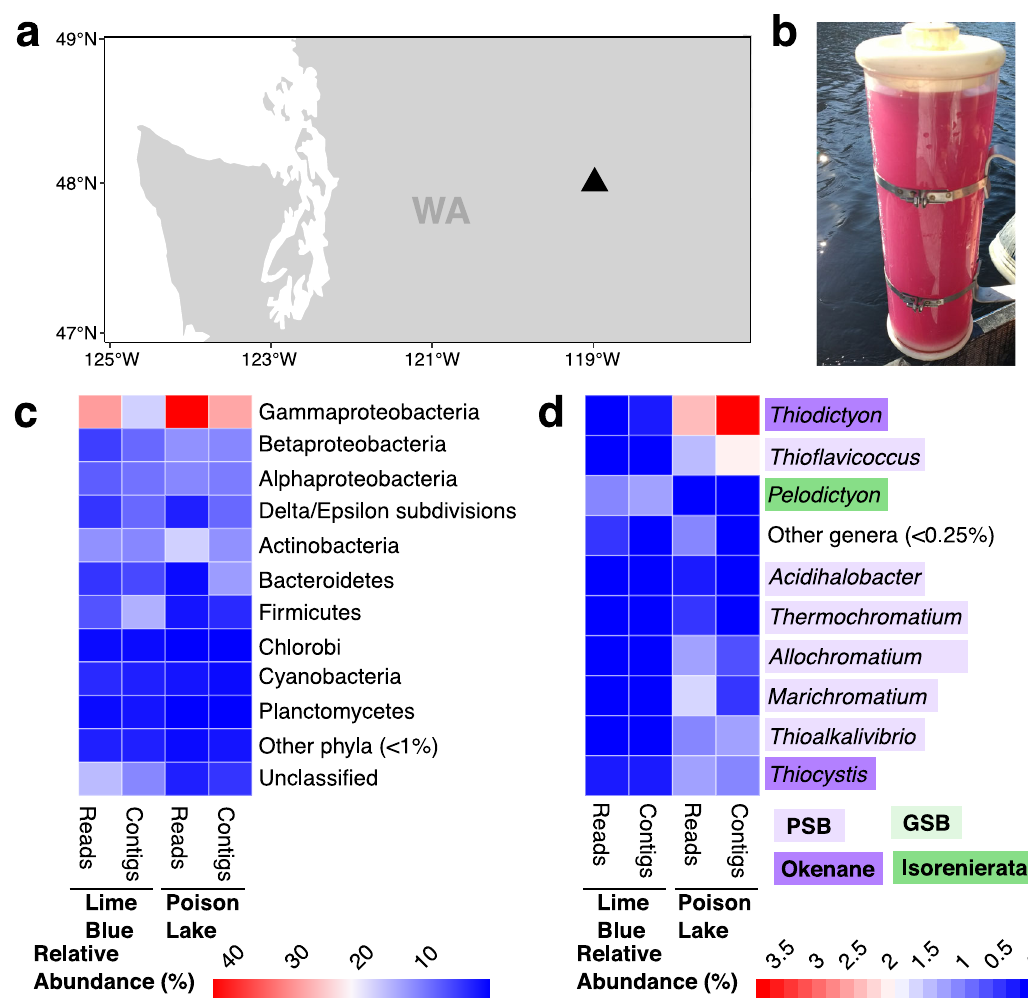
Fig. 1 Sampling sites and bacterial community composition of the two study sites. a Geographic location of sampling sites Poison Lake and Lime Blue in Washington (WA), U.S. b Poison Lake water sample displaying PSB bloom. c Phylum-level read and contig abundances with members of the phylum Proteobacteria split into class level, and ( d ) genus-level abundance of Chlorobi, Chromatiaceae and Ectothiorhodospiraceae . The two sampling sites are denoted as LB, for Lime Blue, and PL for Poison Lake. PSB are highlighted in purple, GSB are highlighted in green, and known producers of the pigments that are precursors of diagenetic products are denoted as indicated in the fi gure legends. In the heatmaps shown in ( c ) and ( d ), relative abundances increase from blue to